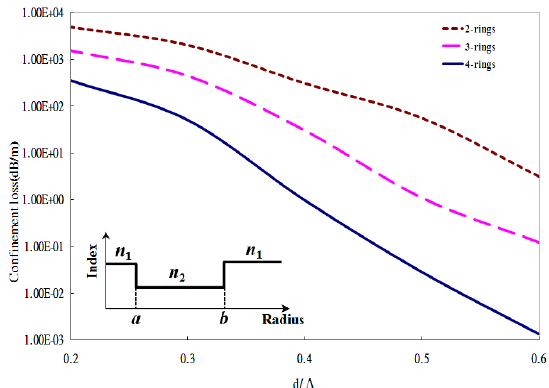
Figure 7. Diagram of confinement losses versus the air-hole size d/ Λ for various numbers of air-hole rings around the solid-core of a PCF.